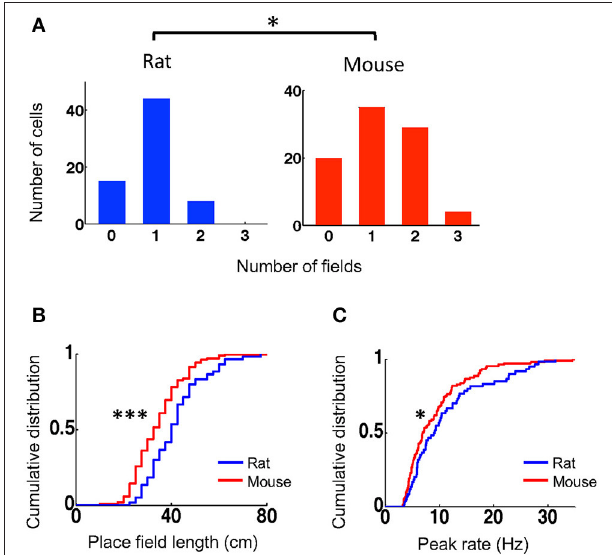
FIGURE 2 | Mouse place cells had more place fields with shorter lengths and lower peak rates than rat place cells. (A) Histograms for rat and mouse place cells with different number of place fields on an active trajectory. * P < 0.05. (B,C) Cumulative distributions of place field length (B) and peak firing rate (C) for rat and mouse place cells on the novel track. *** P < 0.001, * P <